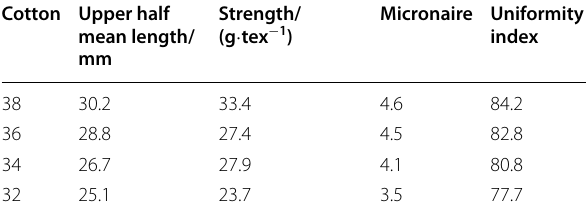
Table 2 HVI calibration cottons used for length group testing Cotton Upper half mean length/